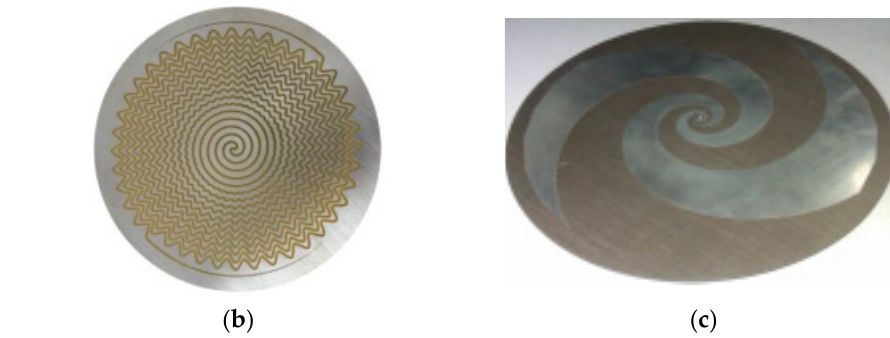
Figure 19. Different designs of spiral antennas: ( a ) the Archimedean spiral antenna studied in [124], ( b ) the cavity ‐ backed cosine slot Archimedean spiral antenna studied in [125], and ( c ) the two ‐ arm equiangular spiral antenna studied in [126].